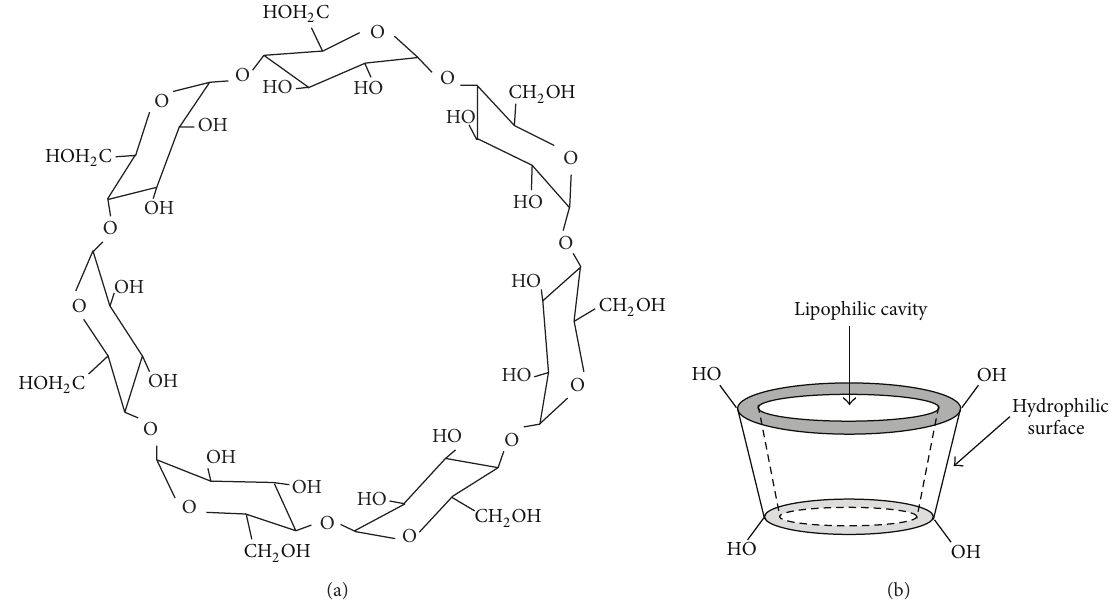
Figure 1: (a) The chemical structure and (b) the toroidal shape of 𝛽